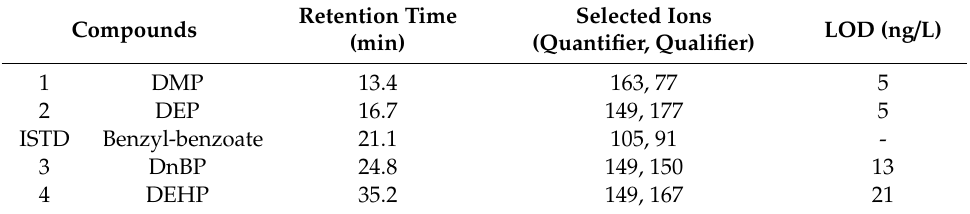
Table 3. Retention time and selected ions for the determination of phthalate esters (PEs). Retention Time Compounds